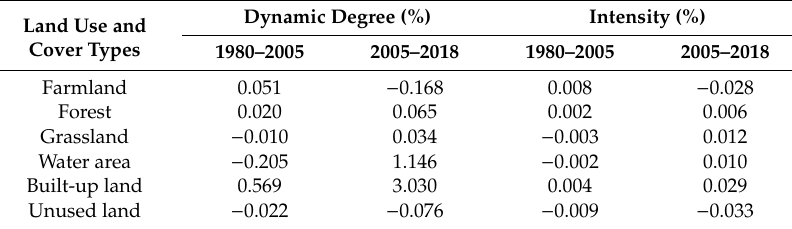
Table 5. Dynamic degree and intensity of LUCC from 1980 to